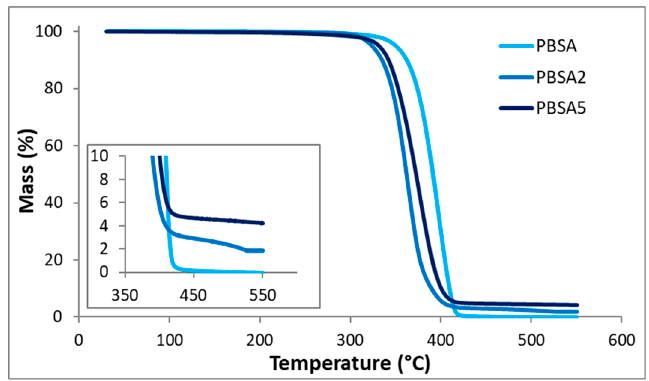
Figure 3. TGA curves obtained for the neat PBSA film and the filled PBSA films.